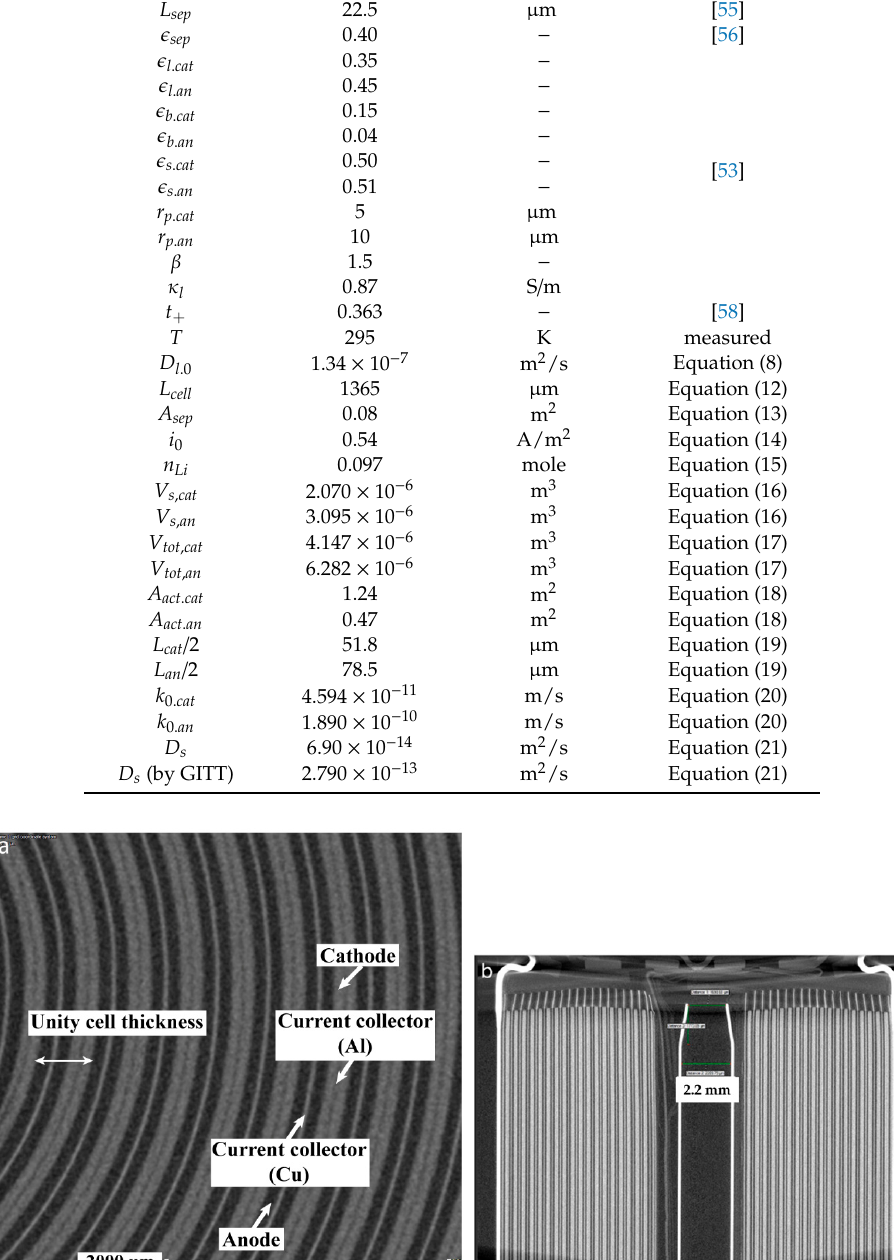
Figure 8. CT images of the modelled Samsung ICR18650-26F 2.6Ah cell for validation purposes. L cell denotes the unity cell thickness: ( a ) Main cell components, ( b ) structure of the electrode, separator and current collector layers as well as the inner diameter of the mandrel for better visual scaling.